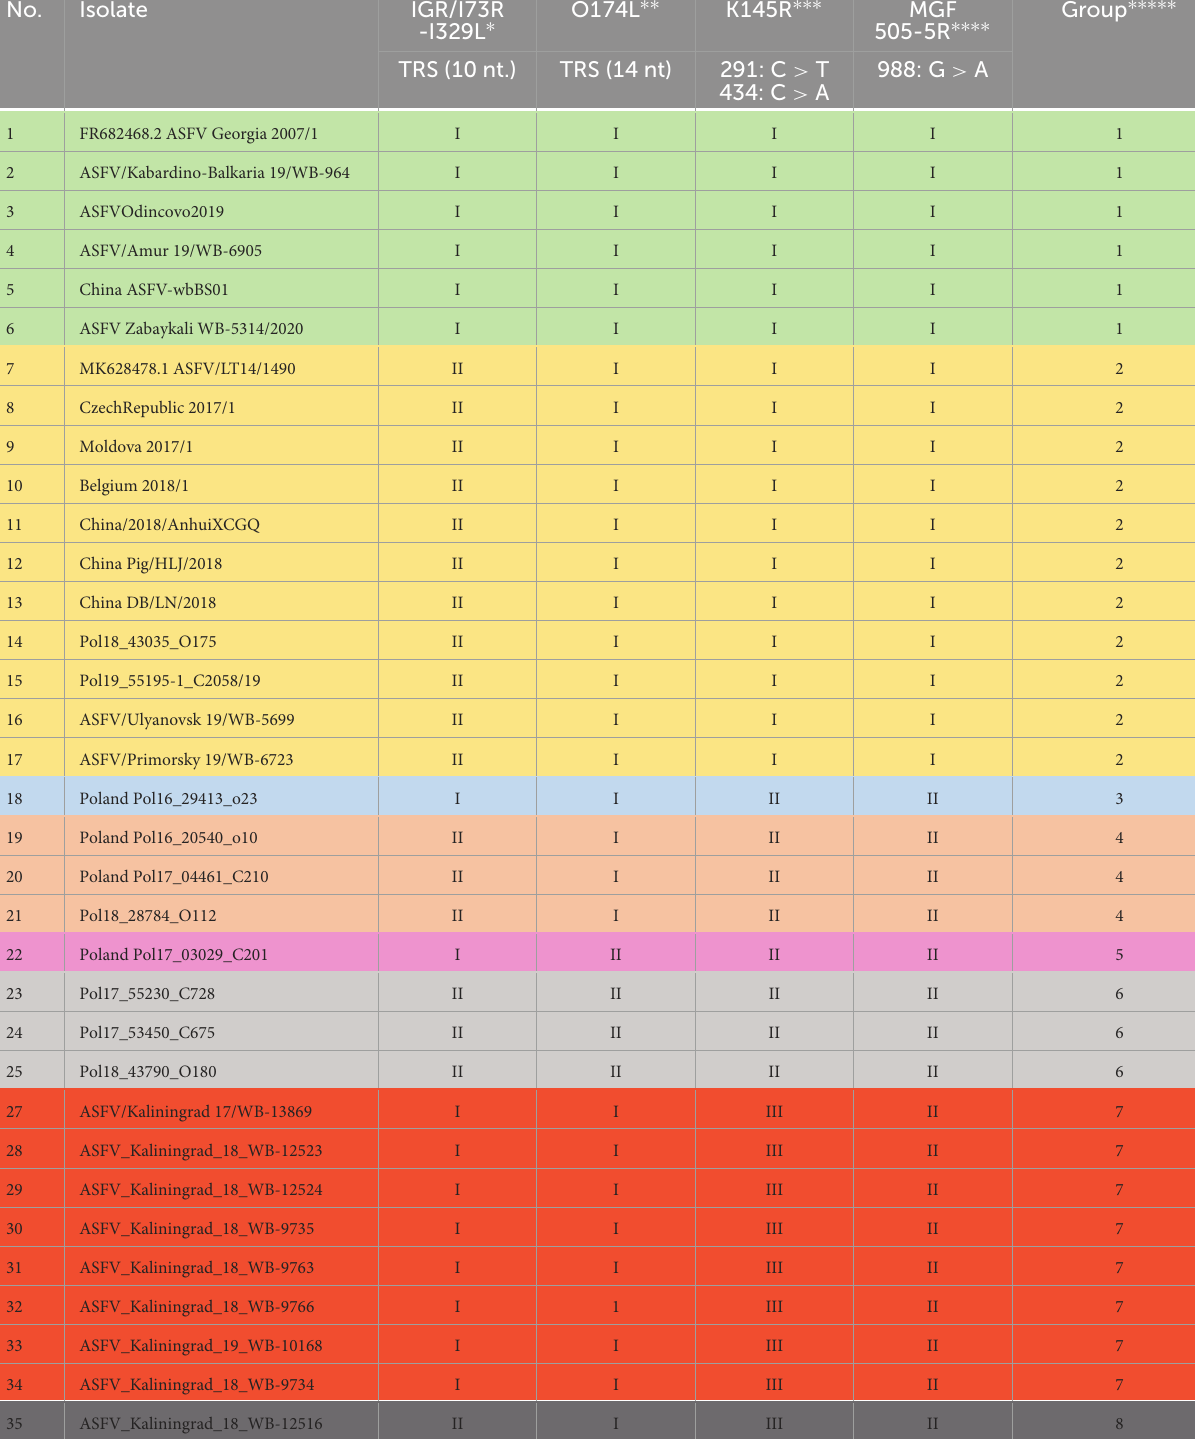
TABLE 4 Clustering of individual isolates based on SNPs or indels observed in the IGR between I73R and I329L, as well as the ORFs O174L, K145R, and MGF-505-5R. No.